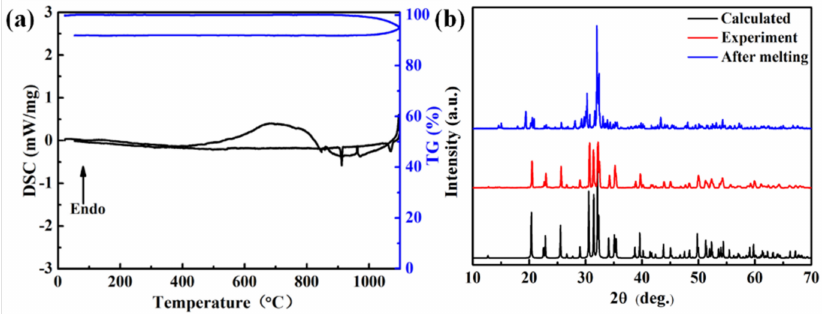
Figure 2. ( a ) Thermal gravimetric (TG) and differential scanning calorimetry (DSC) curves of CIBO ( b ) XRD patterns of simulation, experiment, and after melting for